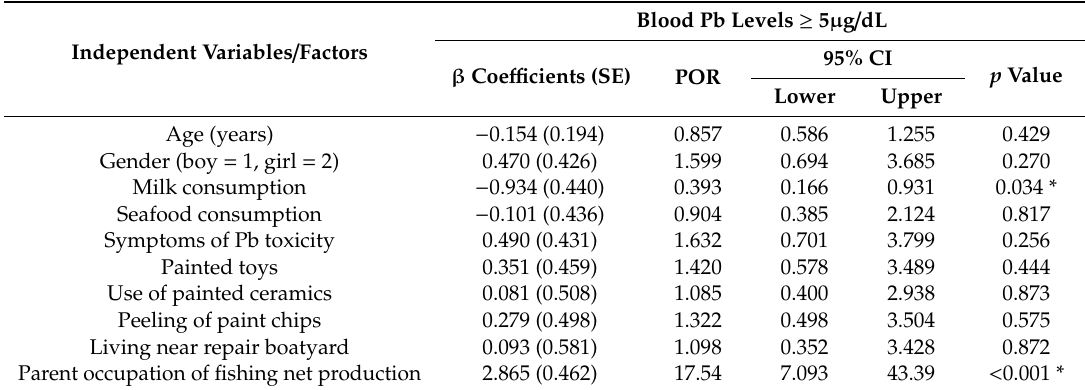
Table 2. Predictors of blood lead levels ≥ 5 µ g / dL.